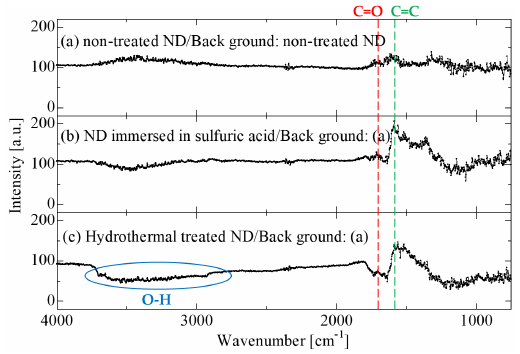
Figure 8. Peak obtained from FTIR measurements.